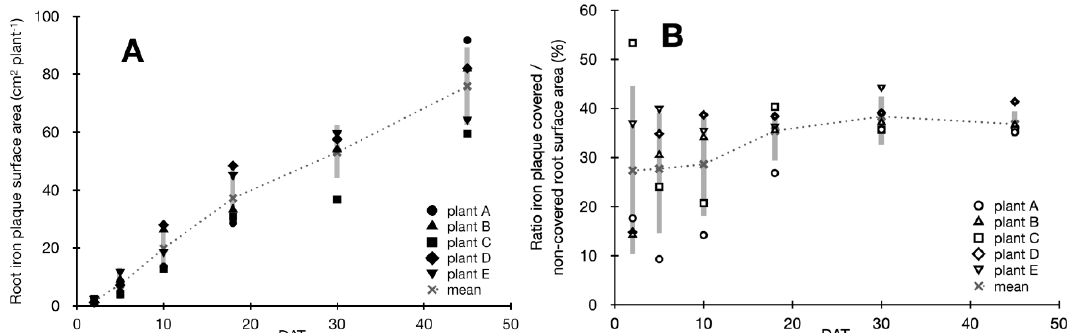
Figure 3. Root iron plaque formation during plant growth. ( A ) Iron plaque mineral surface (cm 2 per plant) on roots during plant growth (DAT = days after transfer) of five replicate plants (filled symbols), mean root iron plaque surface area (cross & punctuated line) and standard deviation (grey bars); ( B ) Ratios of iron plaque-covered to non-covered root surface area (%) in rhizotrons during plant growth over 45 DAT, averaged ratio of all replicates (cross and punctuated line) and standard deviation (grey bars). Iron plaque minerals collected at the end of the growth experiment from (i) the basal root zone (approx. 40 days old), (ii) the middle part of the root (approx. 20 days old), and (iii) the root tips